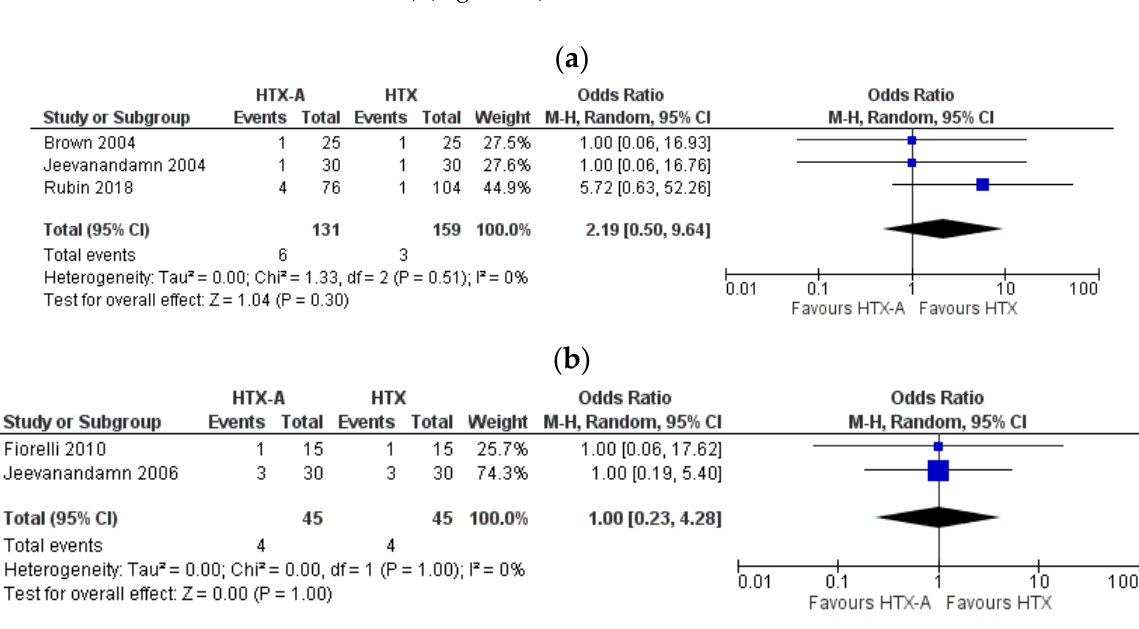
Figure 3. Forest plot depicting periprocedural complications: ( a ) permanent pacemaker implantation rate; ( b ) postoperative severe bleeding rate.